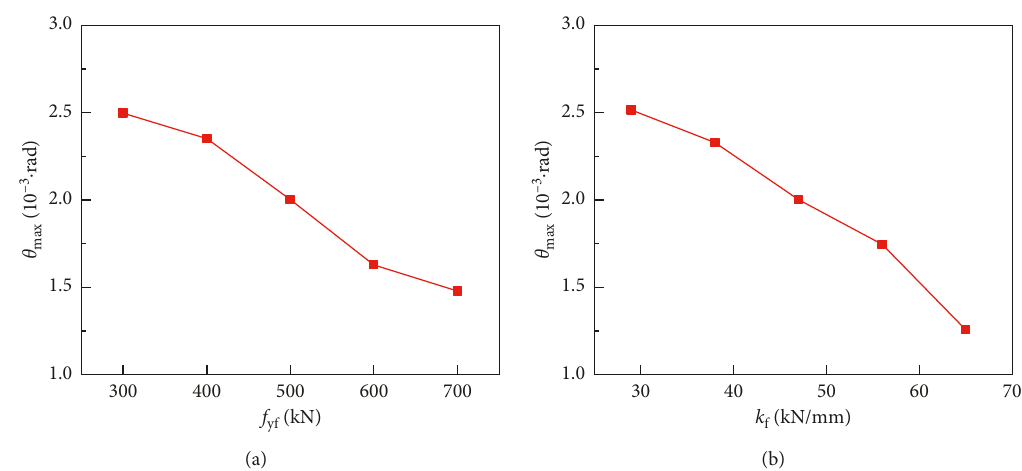
Figure 20: Effects of the parameters regarding the frame. (a) f